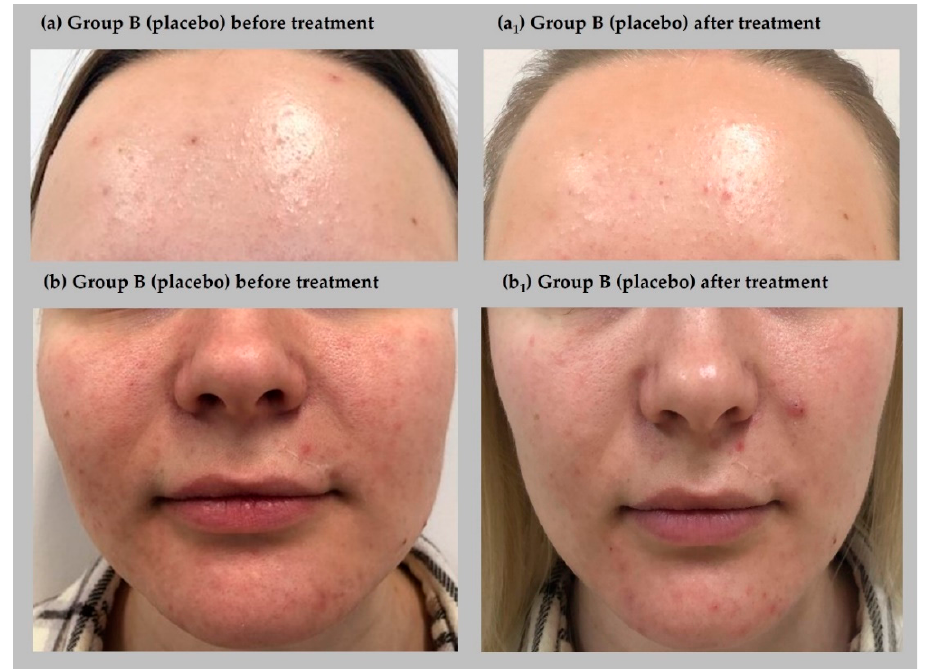
Figure 3. Effect of treatment on acne severity in two patients from group B (placebo) before ( a , b ) and after treatment ( a 1 , b 1 ).